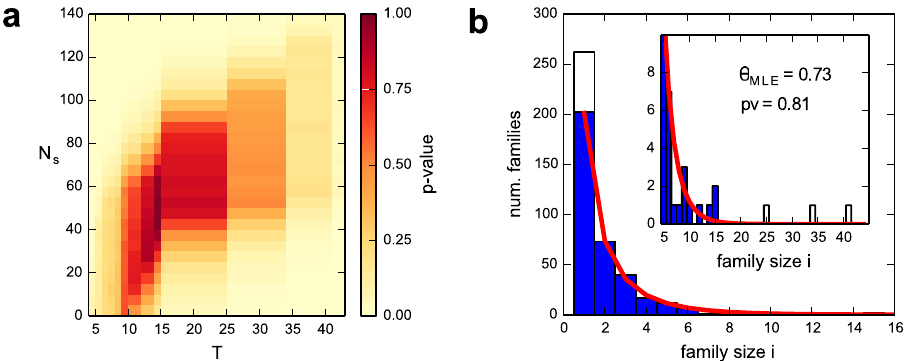
Figure 3. ( a ) Heatmap for the goodness-of-fit p-value as the data sample is reduced. On the x-axis, T indicates the threshold in size above which families are excluded from the sample. On y-axis N s indicates the number of families of size one excluded from the sample. An increase in T or N s reduces the sample size in analysis by reducing the number of TFs considered. For each sample size a goodness-of-fit test for the best-fit model was performed and the corresponding p-value is reported with the color code in the legend. Considering a p-value of 0.75 as the acceptance limit identifies T = 25 as the size threshold at which the fit is acceptable. This corresponds to the exclusion of the three largest families. For such a threshold T , the optimal values for the p-value are reached for values of N s in the range 40 < N s < 80. ( b ) Size distribution of motif families for the reduced sample. The filled distribution represents the motif family size distribution for the reduced dataset, while the original empirical distribution of Fig. 2 is reported with the unfilled bars. The inset shows a zoom on the range of sizes > 5. The line represents the prediction of our model with the best fit choice of the parameter θ , which turns out to fit very well the data contained in the reduced sample with a goodness of fit p-value p ~ 0.8. The best fit value θ = 0.73 does not differ substantially from the value that is obtained by fitting the whole empirical sample as in Fig.